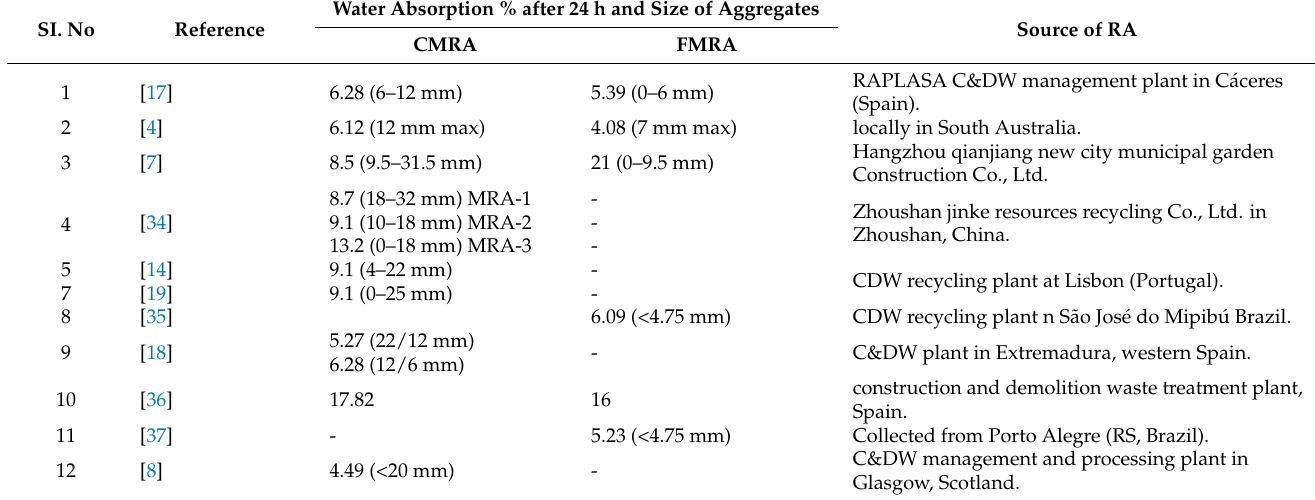
Table 2. Water absorption data from